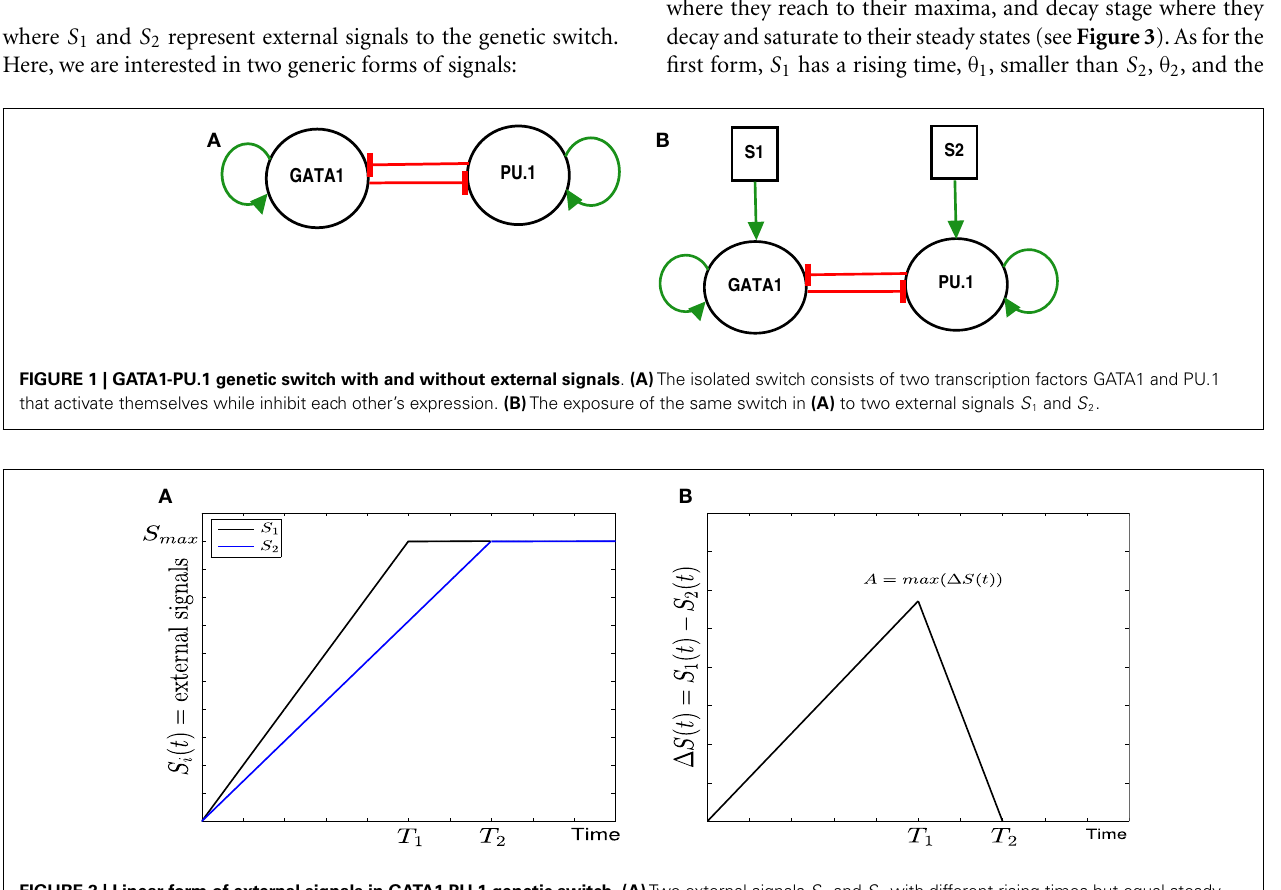
FIGURE 2 | Linear form of external signals in GATA1-PU.1 genetic switch . (A) Two external signals S 1 and S 2 with different rising times but equal steady states at S max = 10. (B) The difference between the external signals with maximal asymmetry at A